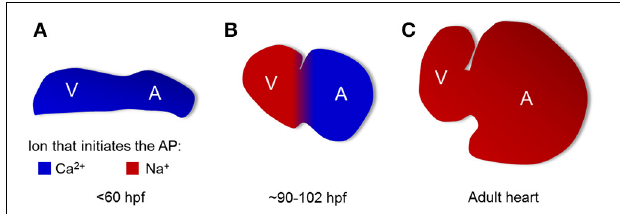
FIGURE 8 | Maturation of cardiac action potential occurs in a chamber-specific manner. Model of ionic currents responsible for AP upstroke at different times in development. (A) At times < 60hpf, Ca 2 + initiates the action potential in both chambers. (B) At an intermediate times (90–102hpf), the atrial AP is driven by Ca 2 + while the ventricular AP is driven by Na + . (C) In the adult, the AP upstroke in both chambers is driven by Na +